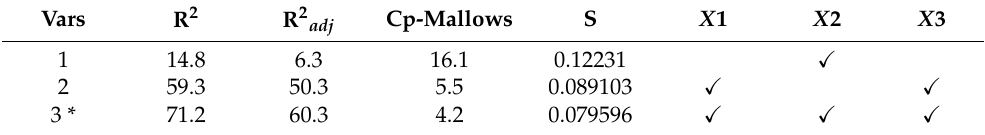
Table 3. Results of best-subset analysis search from MINITAB© for Y 1 (FD mean in µ m), comparing best models with 1, 2 or 3 main parameters only. Selected choice marked with “*”.